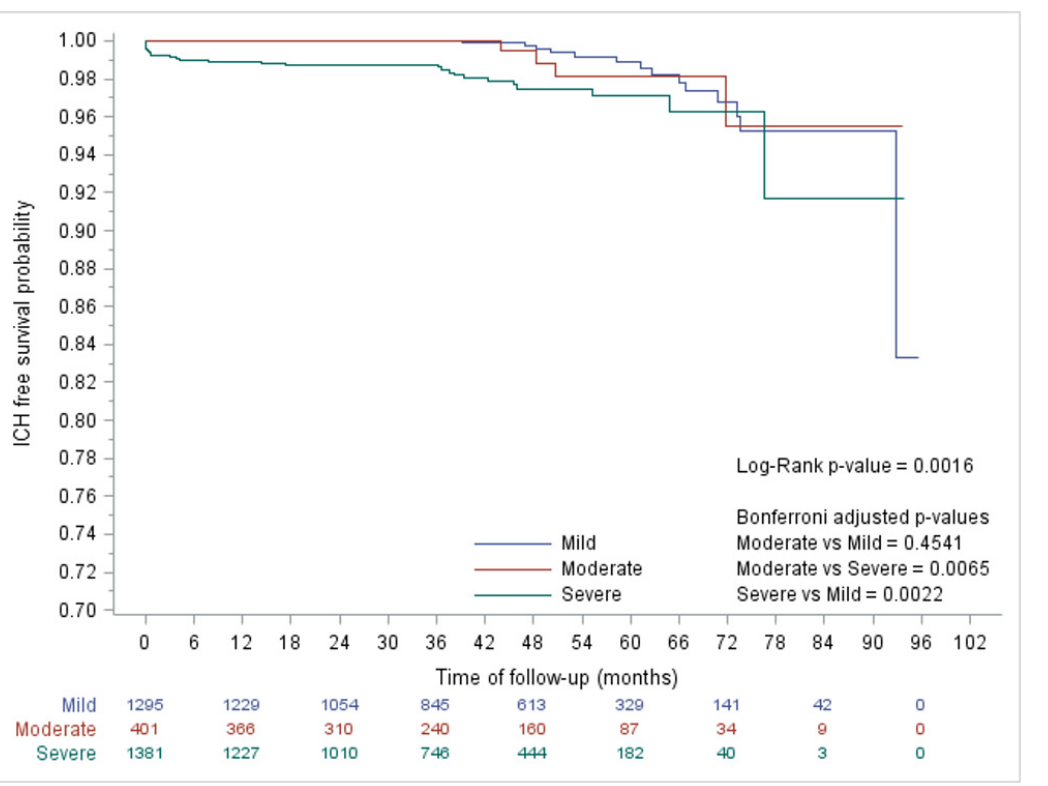
Figure 2. Intracranial haemorrhage (ICH) free survival probability in the different haemophilia de-